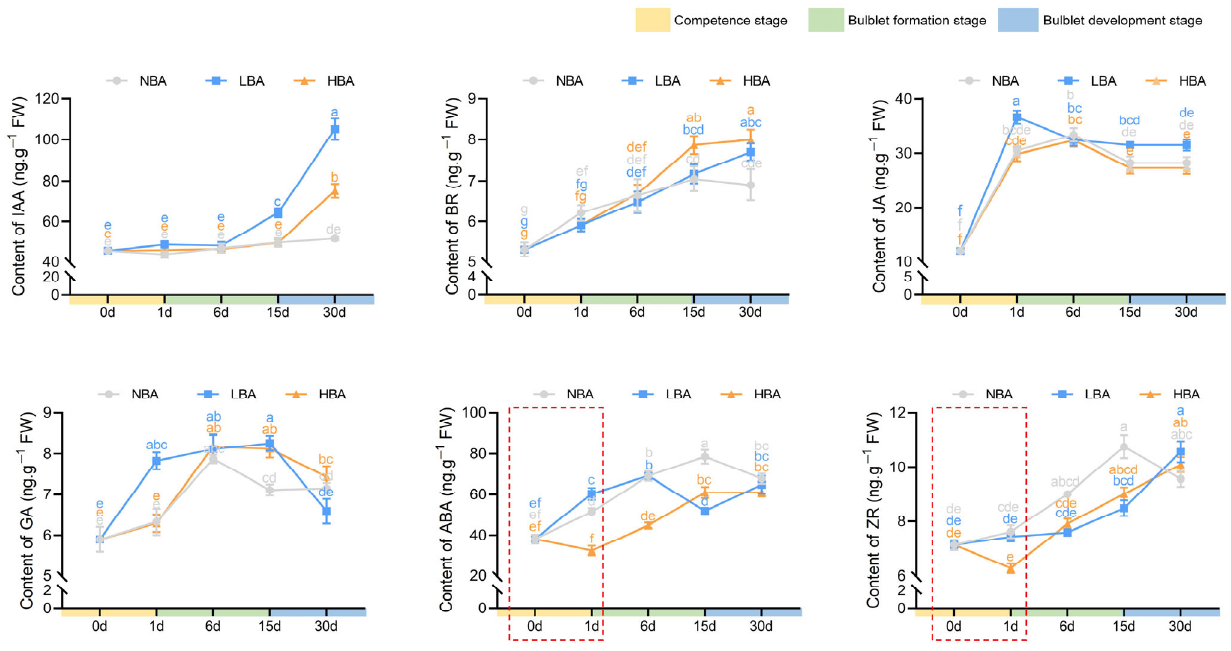
Figure 3. The changes in endogenous hormone contents during the bulblet regeneration process of Lycoris sprengeri in vitro. Data are represented as the means ± SEM ( n = 3 biological replicates). Different letters indicate significant differences at p < 0.05 according to Duncan’s multiple range test. The red dashed frames indicate the different changing trend of hormones among groups during the competence stage.